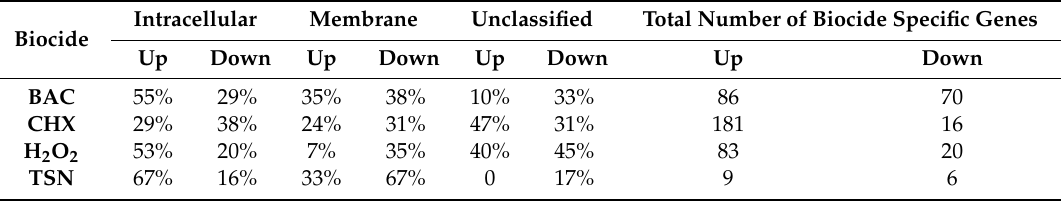
Table 6. Division of the biocide specific genes according to the location of their products in the cell, based on the Gene Ontology category “Cellular component”. The column “Intracellular” contains the genes that express proteins acting in the cytoplasm. The column “Membrane” contains the genes that express proteins acting in the outer membrane, periplasmic space and the inner